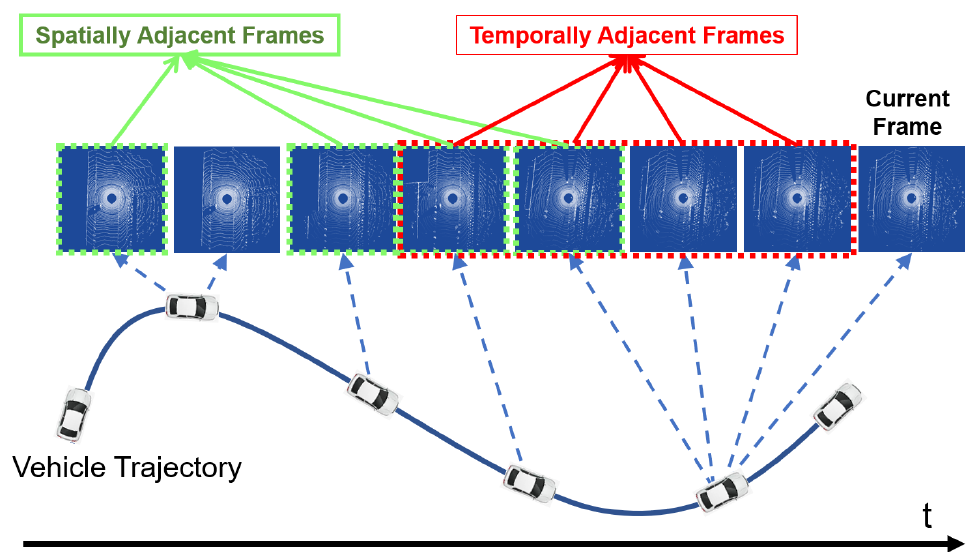
Figure 2. For the current frame F i , its temporal adjacent frames { F i − 1 , F i − 2 ,..., F i − k } is defined as the collection of frames that are temporal close to the current frame. Its spatial adjacent frame is defined as the frames that is spatially close to the current frame, and the distance between any two frames is greater than a distance threshold τ , i.e., { F i − t